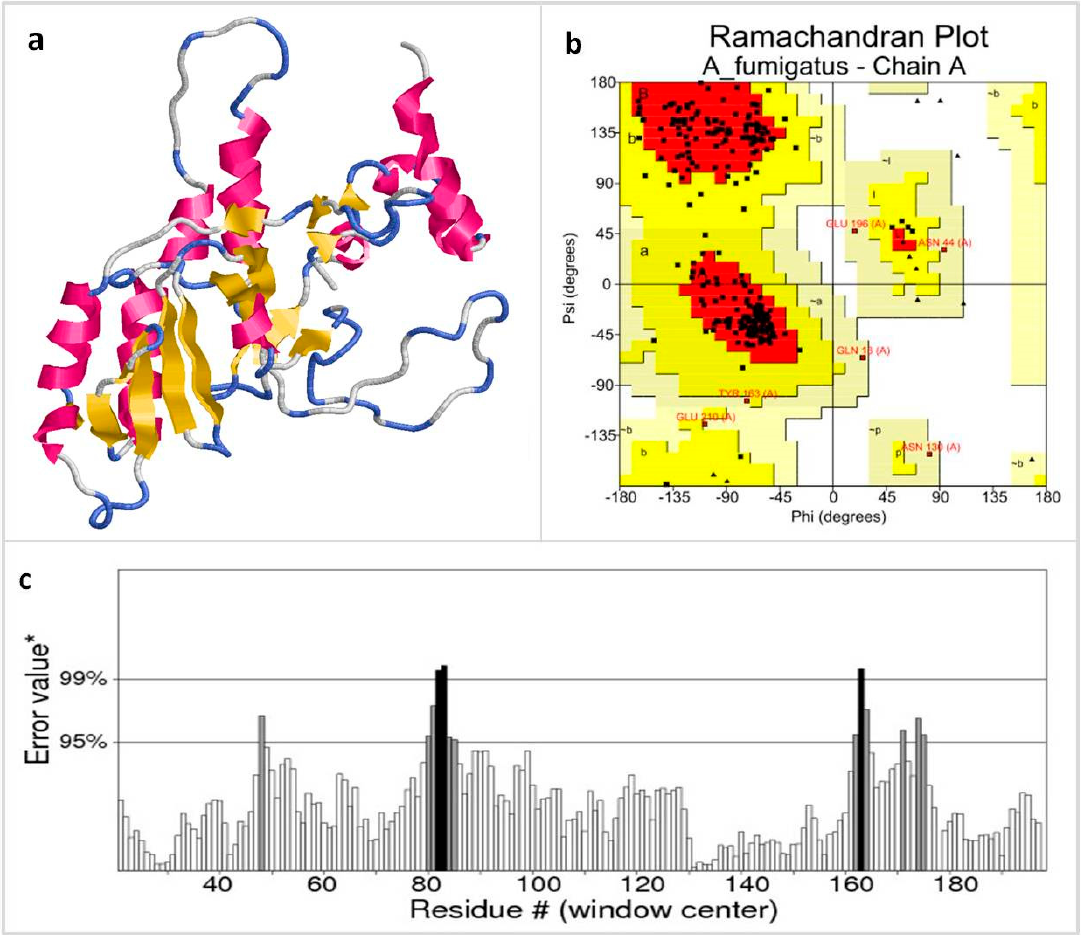
Figure 2. Theoretical model of the RNAP structure from Aspergillus fumigatus and model validation through the SAVES server. ( a ) The 3D structure of the built protein in a cartoon representation with the following structure colors: Pink (helices), Yellow (sheets), and blue (loop); ( b ) model validation by a Ramachandran plot; ( c ) ERRAT Plot showing the generated model at a good high resolution, as the regions of the modeled structure that can be rejected at 95% and 99% confidence is very low.